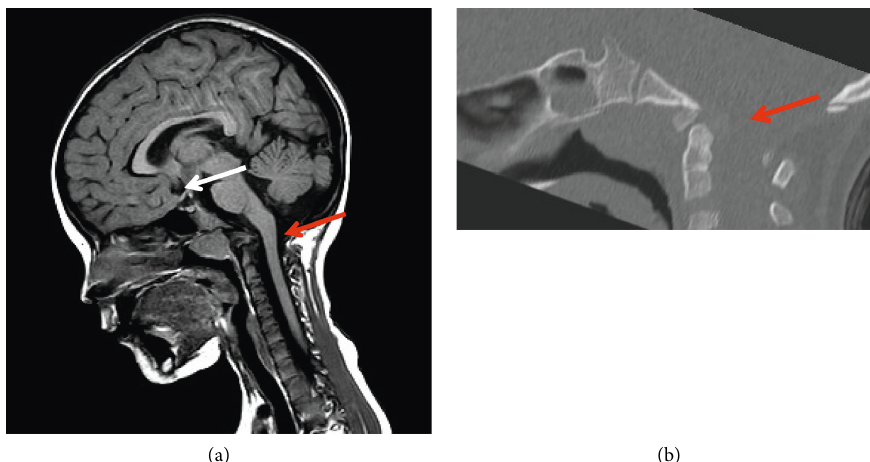
Figure 1: Magnetic resonance sagittal T1 showing the ectopic bright spot of posterior pituitary located along the cranial part of the pituitary stalk (white arrow in Panel (a)). A constitutional dysmorphism of the craniocervical junction characterized by platybasia and basilar footprint with the agenesis of the left posterior hemiarch of the first cervical vertebra (red arrow in Panel (a) and (b)) was also noted. Table 1: Hormonal dosages. At endocrinological evaluation Normal